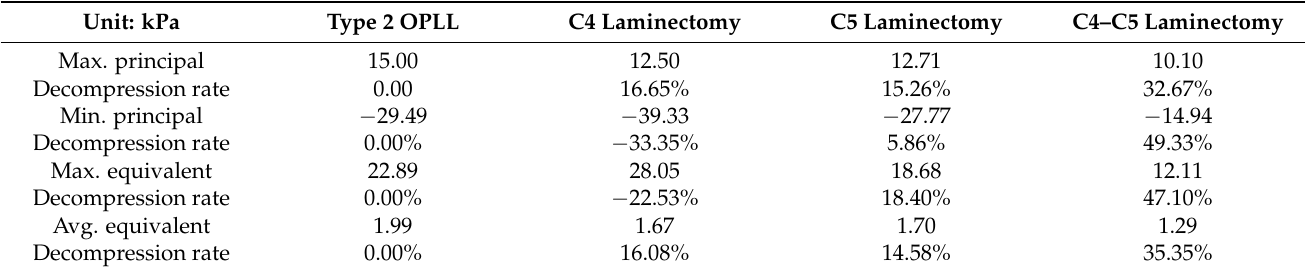
Table 8. Flexion laminectomy simulation spinal cord stresses: type 2 OPLL.